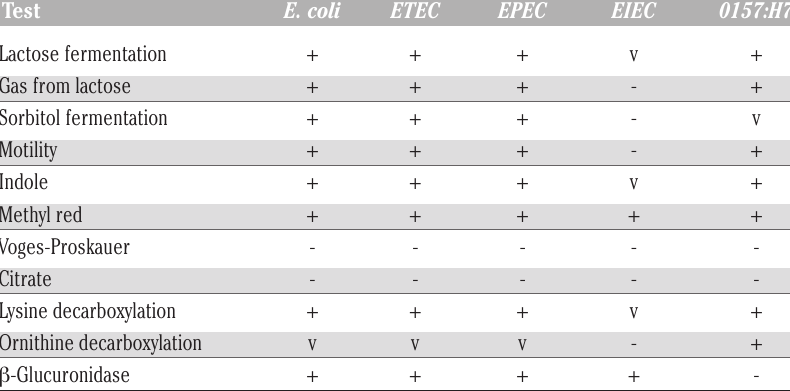
Table 3. Biochemical properties of E. coli . 66